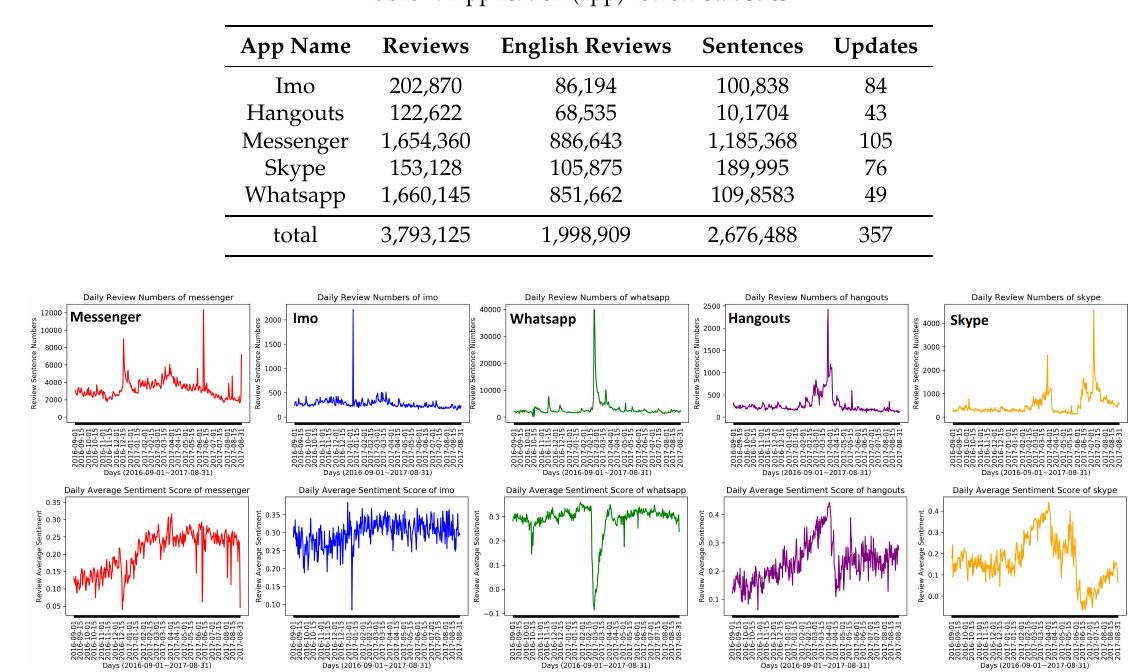
Figure 3. Number of reviews and average sentiment score by day (from 2016-09-01 to